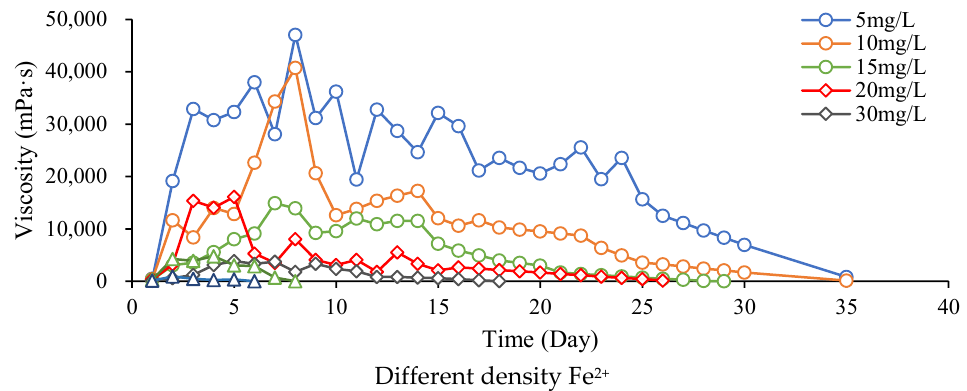
Figure 6. Effects of Fe 2+ and Fe 3+ on the gel-forming properties of weak gels.